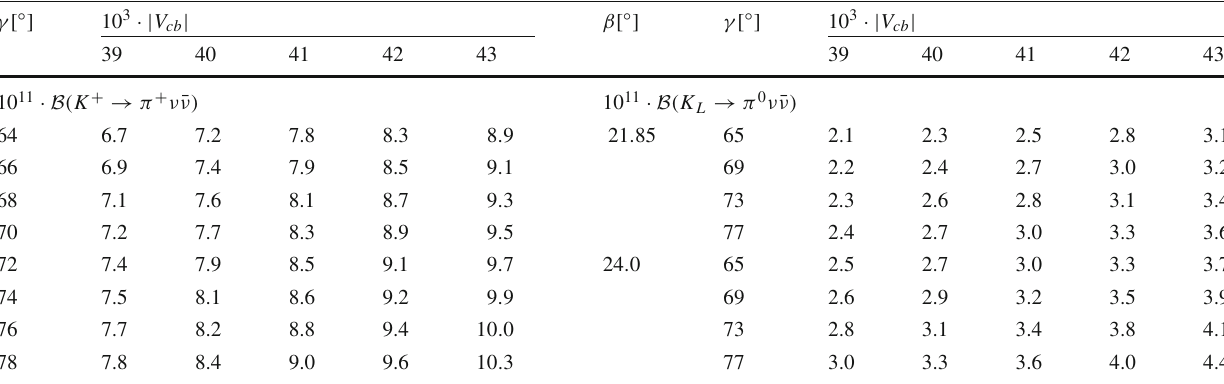
Table 2 Left: Central values for the branching ratio B ( K + → π + ν ¯ ν) for various values of γ and | V cb | . The angle β is fixed to β = 21 . 85 ◦ determined from S ψ K . Right: Central values for the branching ratio B ( K L → π 0 ν ¯ ν) for various values of β , γ and | V cb S